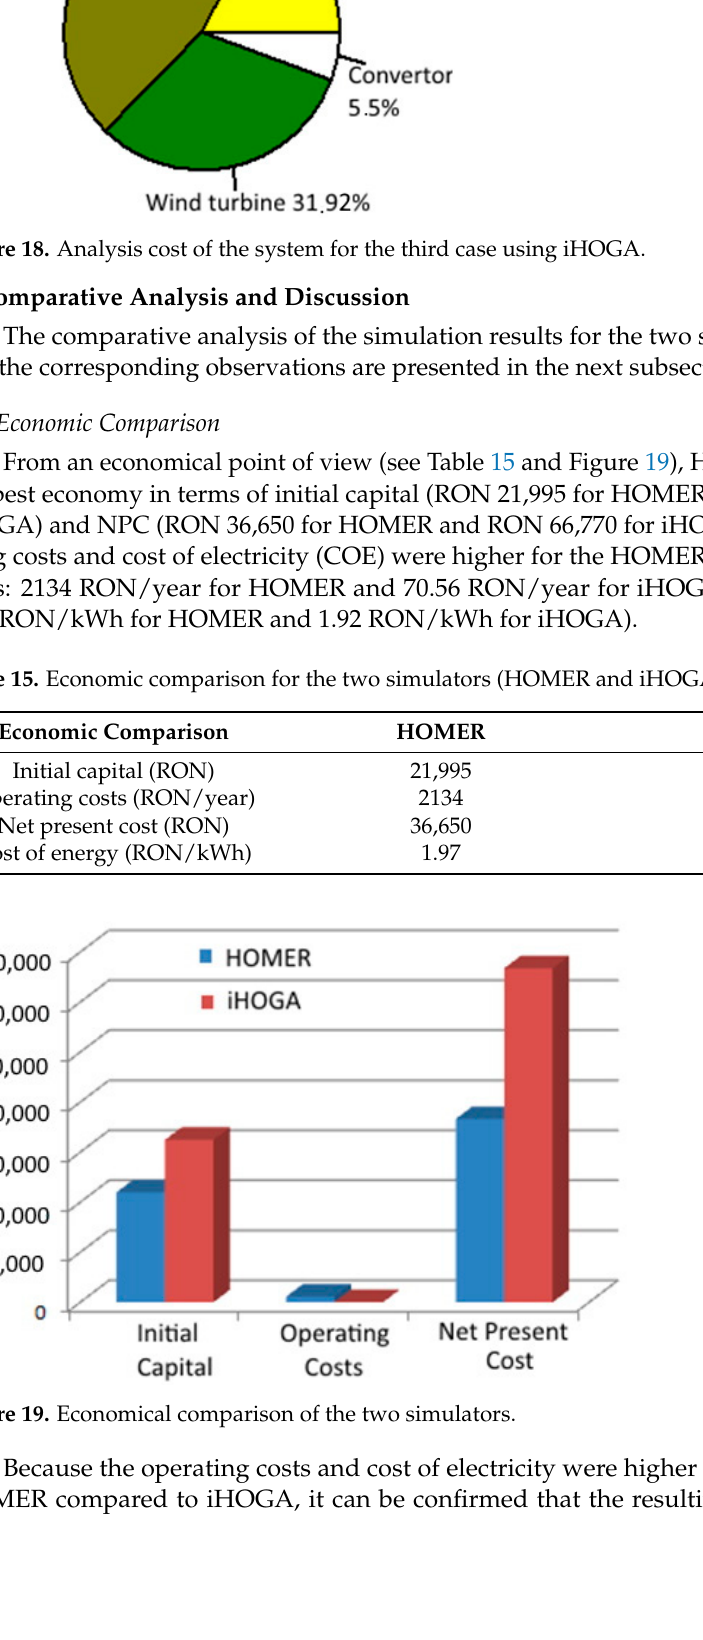
19 of 26 Figure 17. System components of the simulation for the third case using iHOGA. Table 11 shows the annual production using the iHOGA simulator based on the sim- ulation results. From Table 14, it can be seen that annual energy produced was 1930 kWh/year and annual energy consumption was 1389 kWh/year, with photovoltaic panels having the greatest contribution to energy production at 1392 kWh/year (representing 72.12% of the total annual energy production). The second contribution to energy produc- tion was by the wind turbine at 538 kWh/year (representing 27.88% of the total annual production). Table 14. The annual production for the third case using iHOGA simulator. Component